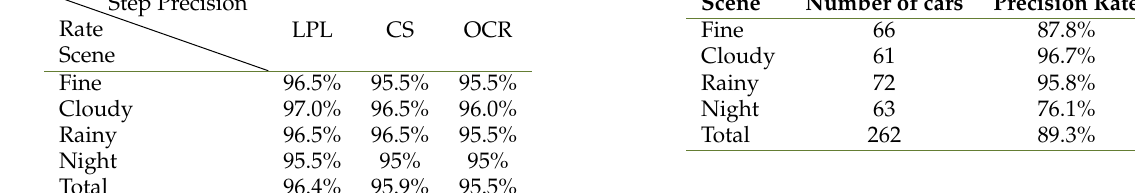
Table 6. Time-consuming scale of each